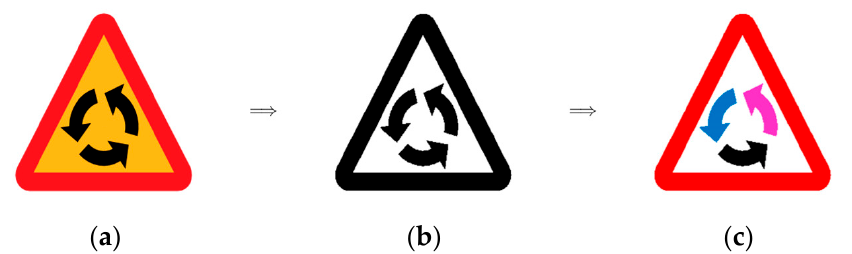
Figure 17. Experimental comparison of CF, SAUF, and NULL.